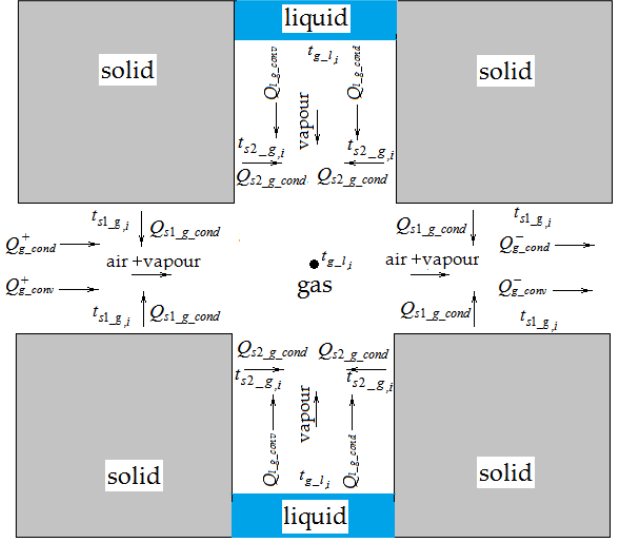
Figure 4. Scheme of heat transfer for the gas phase in an elementary cubic element.